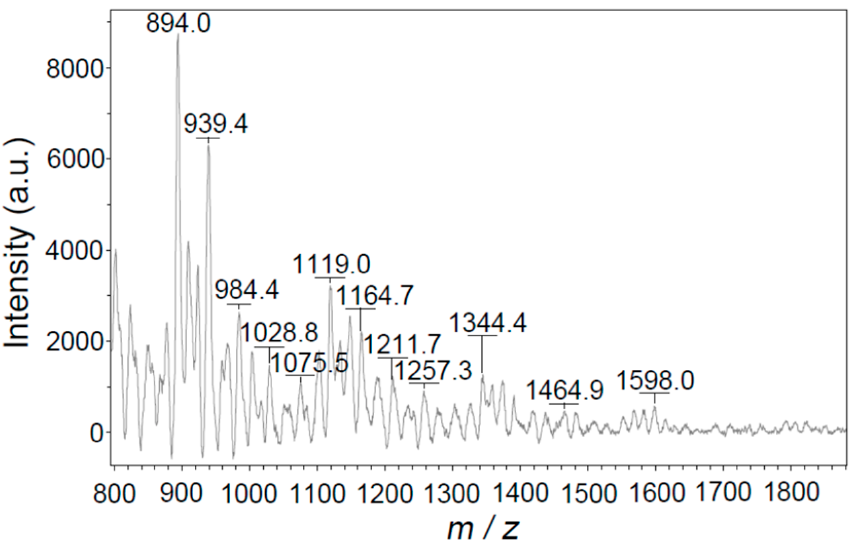
Figure 4. Matrix-assisted laser desorption/ionization/time-of-flight (MALDI/TOF) mass spectrum of tetrahydrofuran (THF) soluble part of PTT prepared with a CuCl 2 /TT molar ratio of 1.0 and a TT concentration of 0.38 mol·L − 1 in DMF at 25 °C for 24 h.